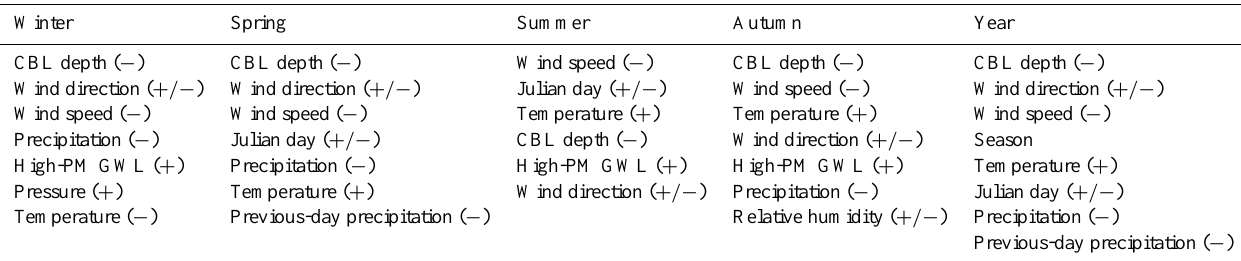
Table 2. List of explanatory variables selected in GAMs for PM 2 . 5 . Explanatory variables that were chosen for at least five (out of seven) stations are listed. Positive signs ( + ) next to variable names indicate a positive relationship between PM 2 . 5 and the explanatory variable, whereas negative signs ( − ) represent the opposite. Use of both signs ( + / − ) indicates relationships with turning points or variables whose behavior depends on the station. More frequently chosen variables are displayed